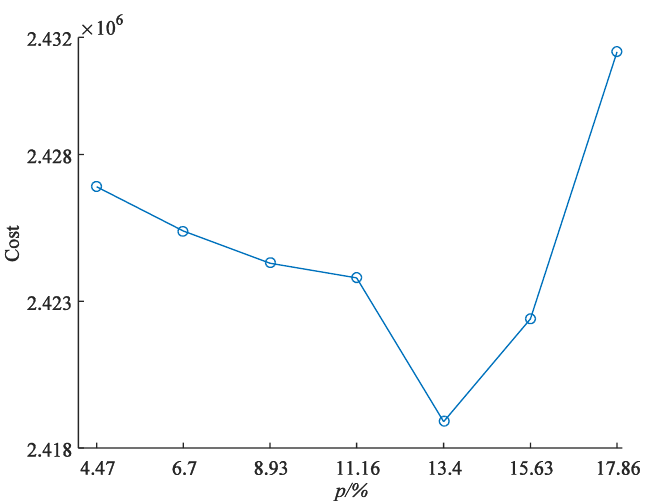
Figure 13. Curve of best fuel cost varies with penetration.